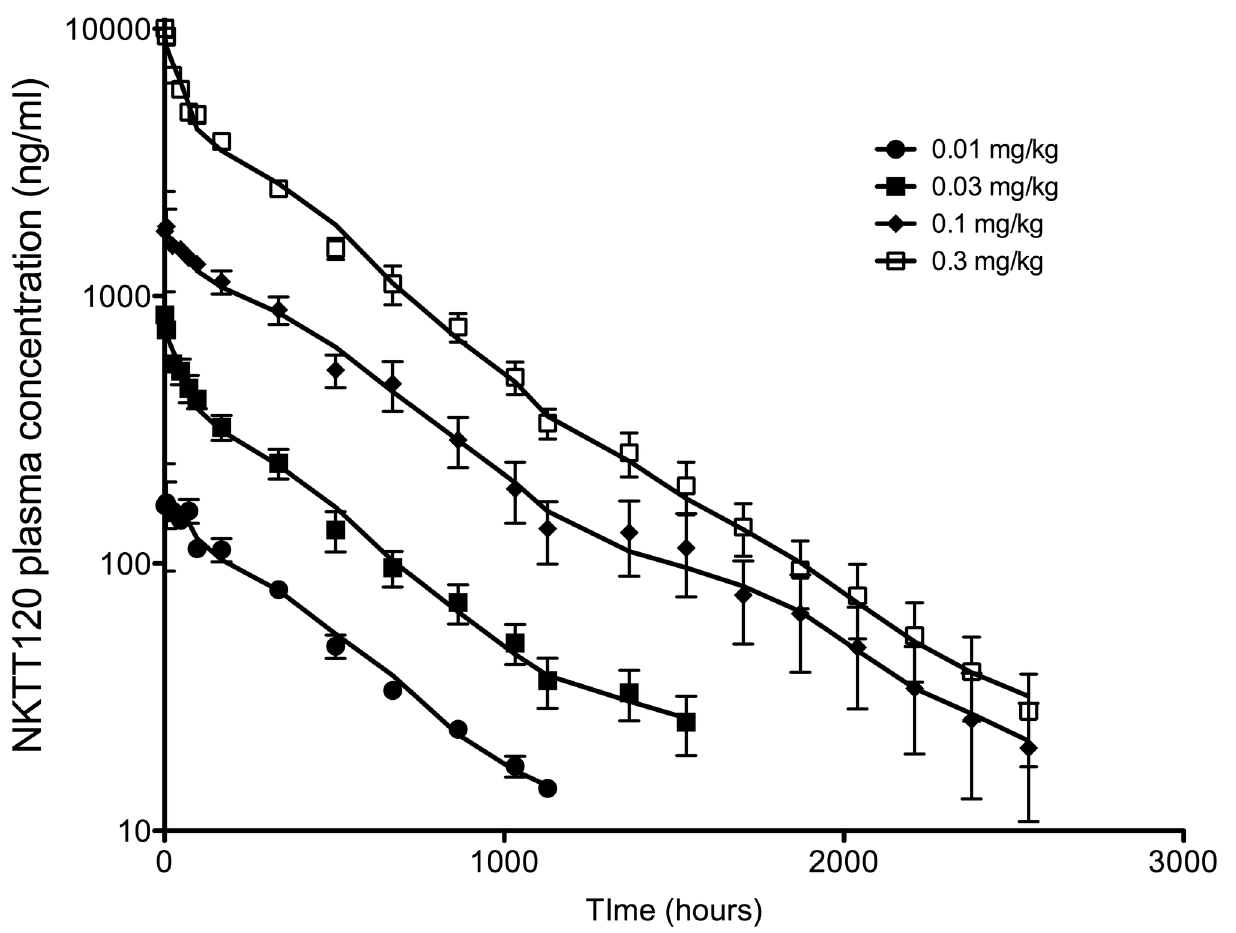
Figure 2. Cynomolgus macaques (n=3 per dose group) were dosed with a single dose of 0.01 mg/kg (filled circles), 0.03 mg/kg (filled squares), 0.1 mg/kg (filled diamonds) and 0.3 mg/kg (open squares) of NKTT120, respectively and subsequently bled at indicated time points. NKTT120 plasma concentrations were measured by ELISA. Shown are means within groups with standard